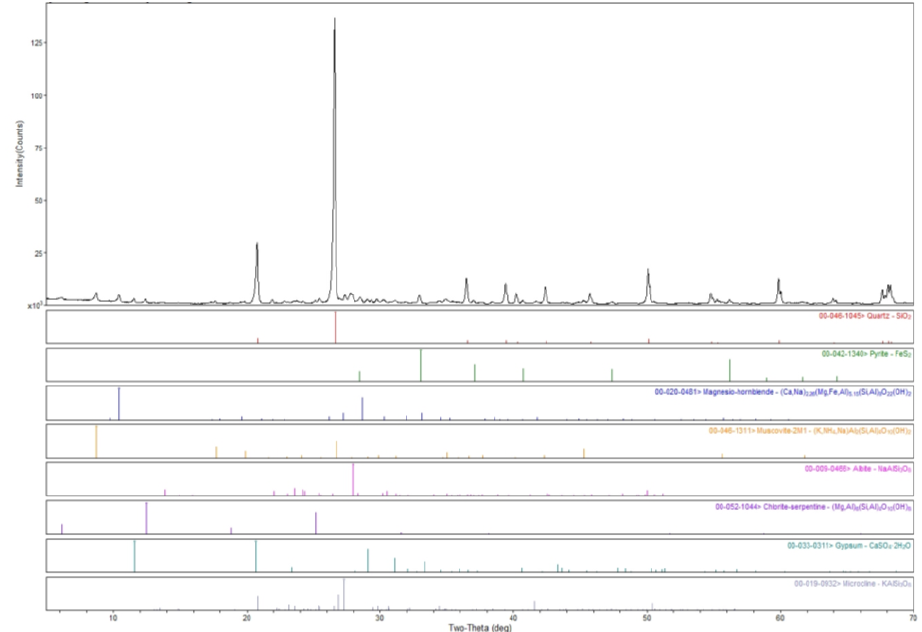
Table 4. Mineral phases quantified by TESCAN Integrated Mineral Analyzer (TIMA) analysis.